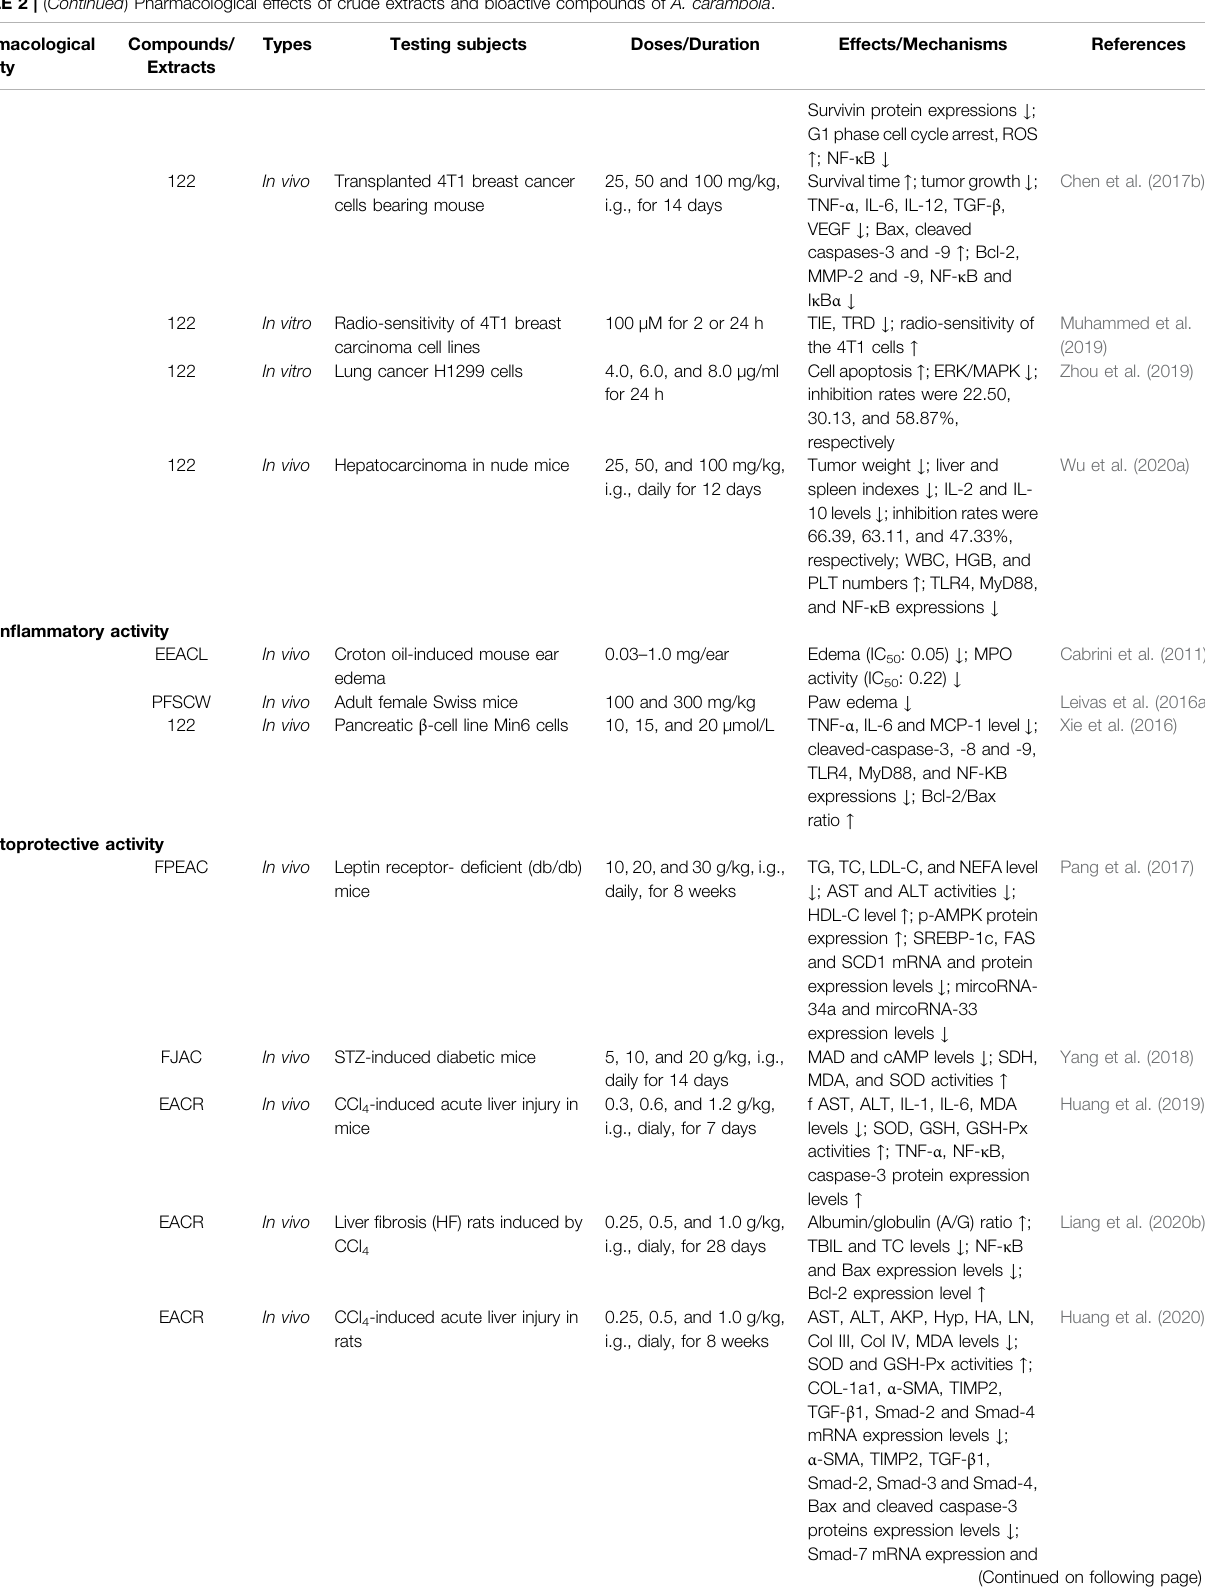
TABLE 2 | ( Continued ) Pharmacological effects of crude extracts and bioactive compounds of A. carambola